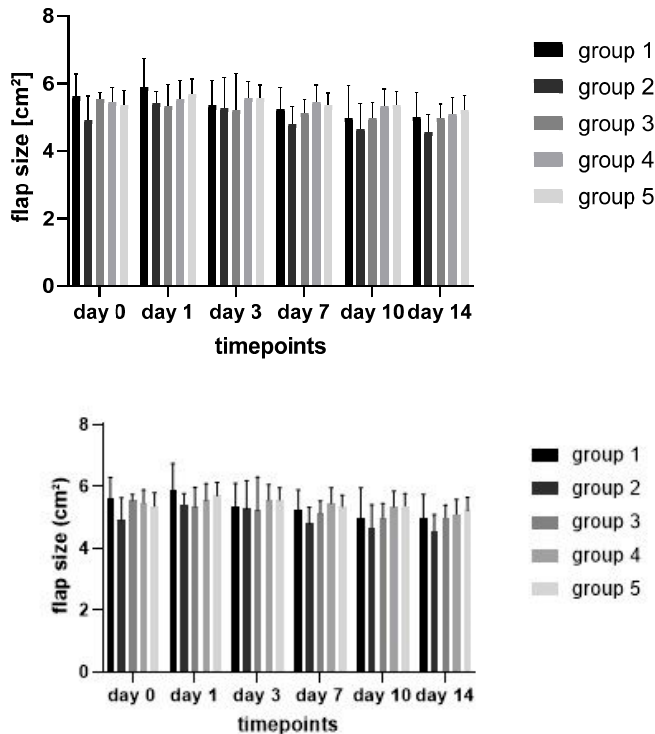
Figure 5. Flap size over time in the different treatment groups.